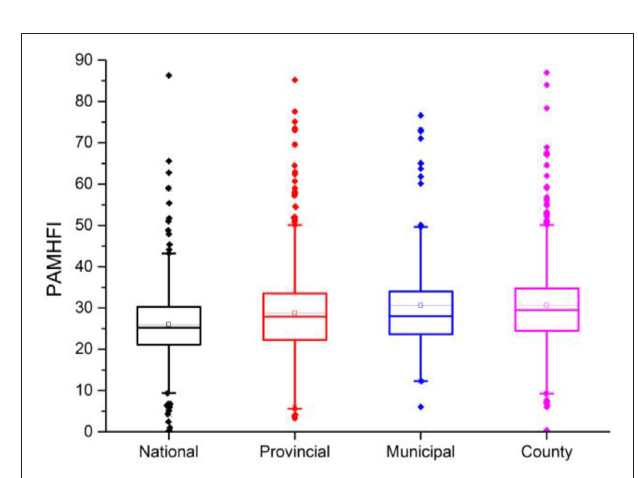
FIGURE 3 | Box plot of PAMHFI distribution for PAs managed at different governance levels, across all PA categories.